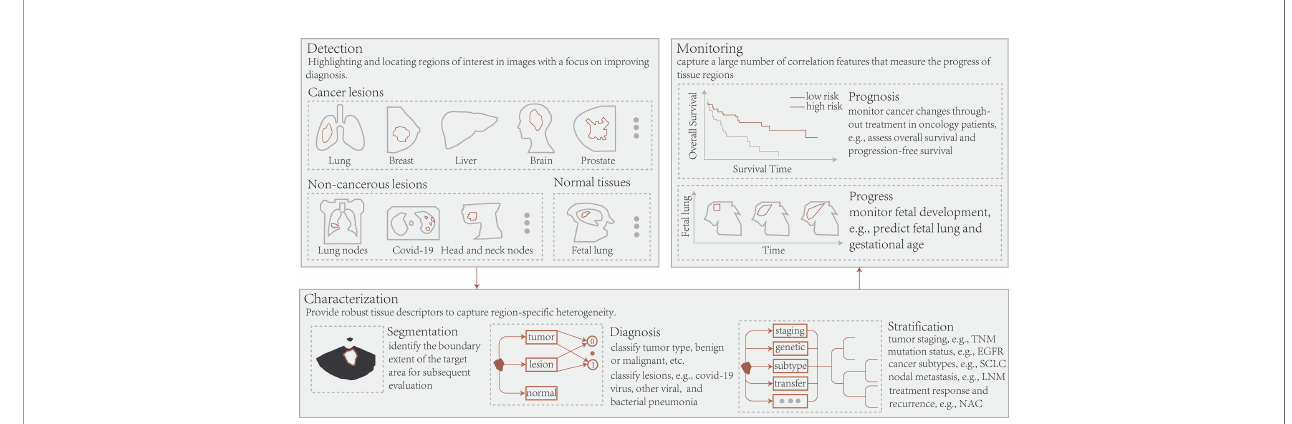
FIGURE 3 | Conceptually, radiomics and deep learning in radiology allow the application of three essential types of image-based clinical tasks: 1) Detection of regions of interest, including cancerous, non-cancerous, and normal tissue; 2) Segmentation of target regions, disease diagnosis, and patient strati fi cation; 3) Treatment response or prognosis and tissue progression. TNM, tumor node metastasis; EGFR, epidermal growth factor receptor; SCLC, small cell lung cancer; LNM, lymph node metastasis; NAC, neoadjuvant